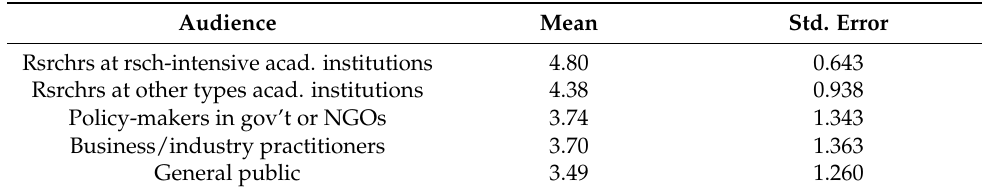
Table 10. The importance of accessibility for different audiences.